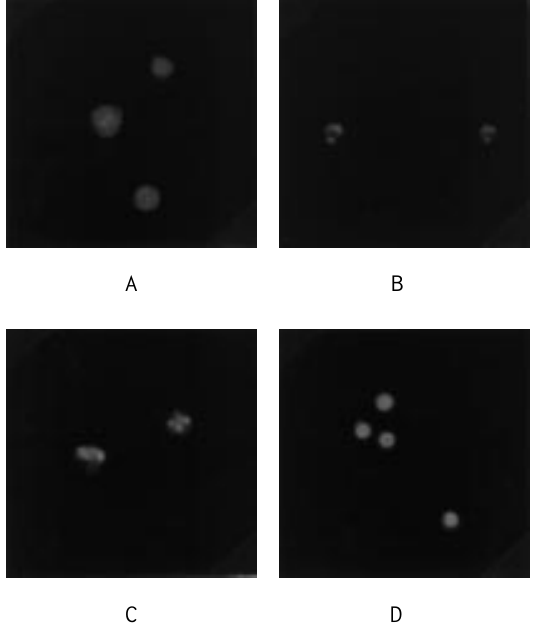
Fig. 3. Morphology of HL60 cells stained by acridine orange/ ethidium bromide: A, viable cells; B, early apoptotic cells; C, late apoptotic cells; and D, necrotic cells. (cid:2) 200 magnification.